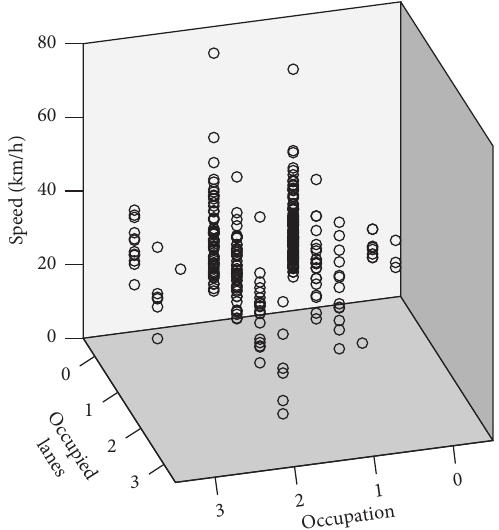
Figure 11: Relationship between occupation, traveling speed, and illegal lane occupation behavior.